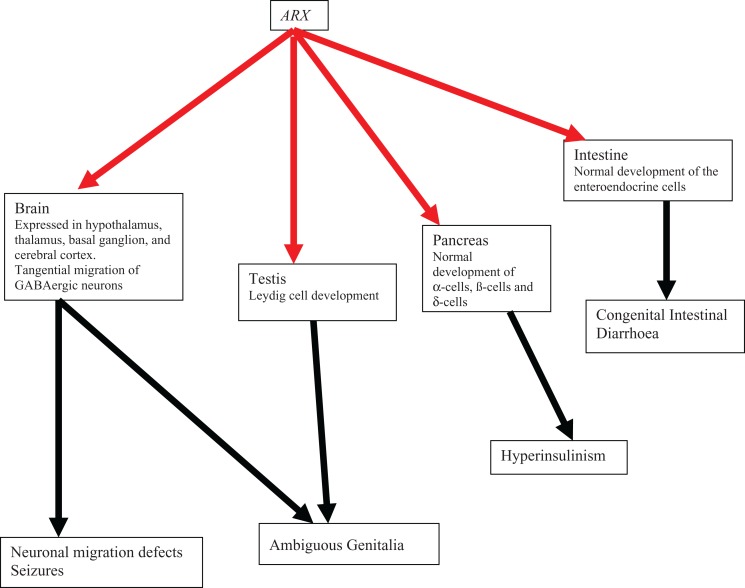
The ARX roles in embryogenesis and phenotypes. Solid red arrows indicate roles in normal embryogenesis. Solid black arrows depict phenotypes consequent to perturbations in ARX function in embryogenesis. ARX indicates aristaless-related homeobox.